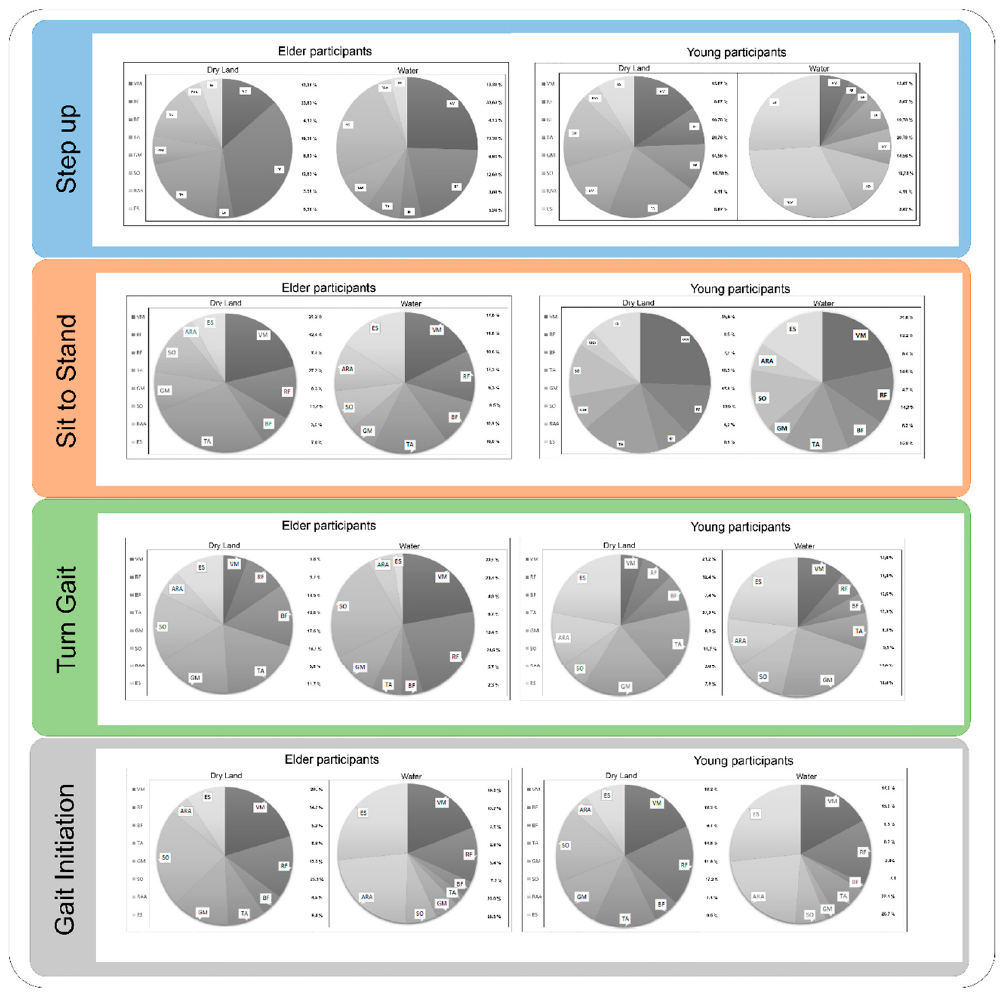
Figure 2. Precentage of relative participation of analyzed muscles during for each one of the tests/movements analyzed, considering, on the one hand, the group that executes it (older/younger) and the execution environment (Dry/aquatic). BF: biceps femoris; ES: erector spinae; GM: gastrocnemius Medialis; RAA: rectus abdominis; RF: rectus femoris; SO: soletus; TA: tibialis anterior; VM: vastus